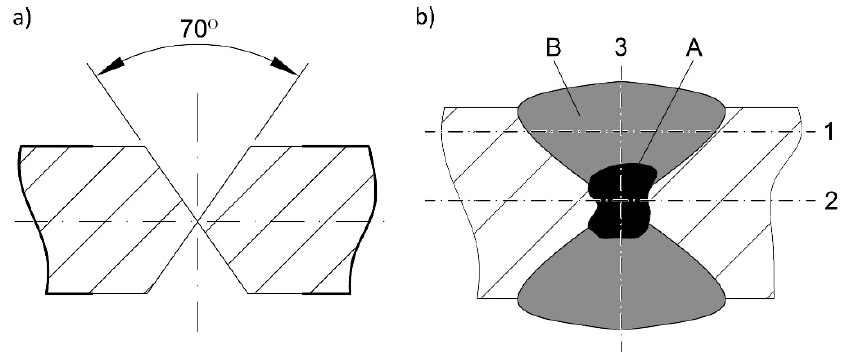
Figure 2. Layout of Hardox 600 welded joints: ( a ) prepared sheet edges; and ( b ) building of weld metal during welding: A—weld metal UltraMag; B—weld metal Aristorod 89; 1, 2, 3—lines of hardness measurements.